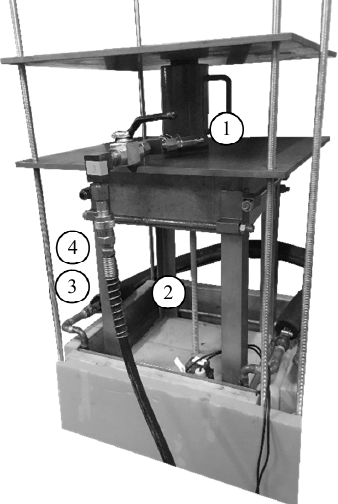
Figure 7. Deformation of the test specimen over the test period at an insulation thickness of 350 mm.